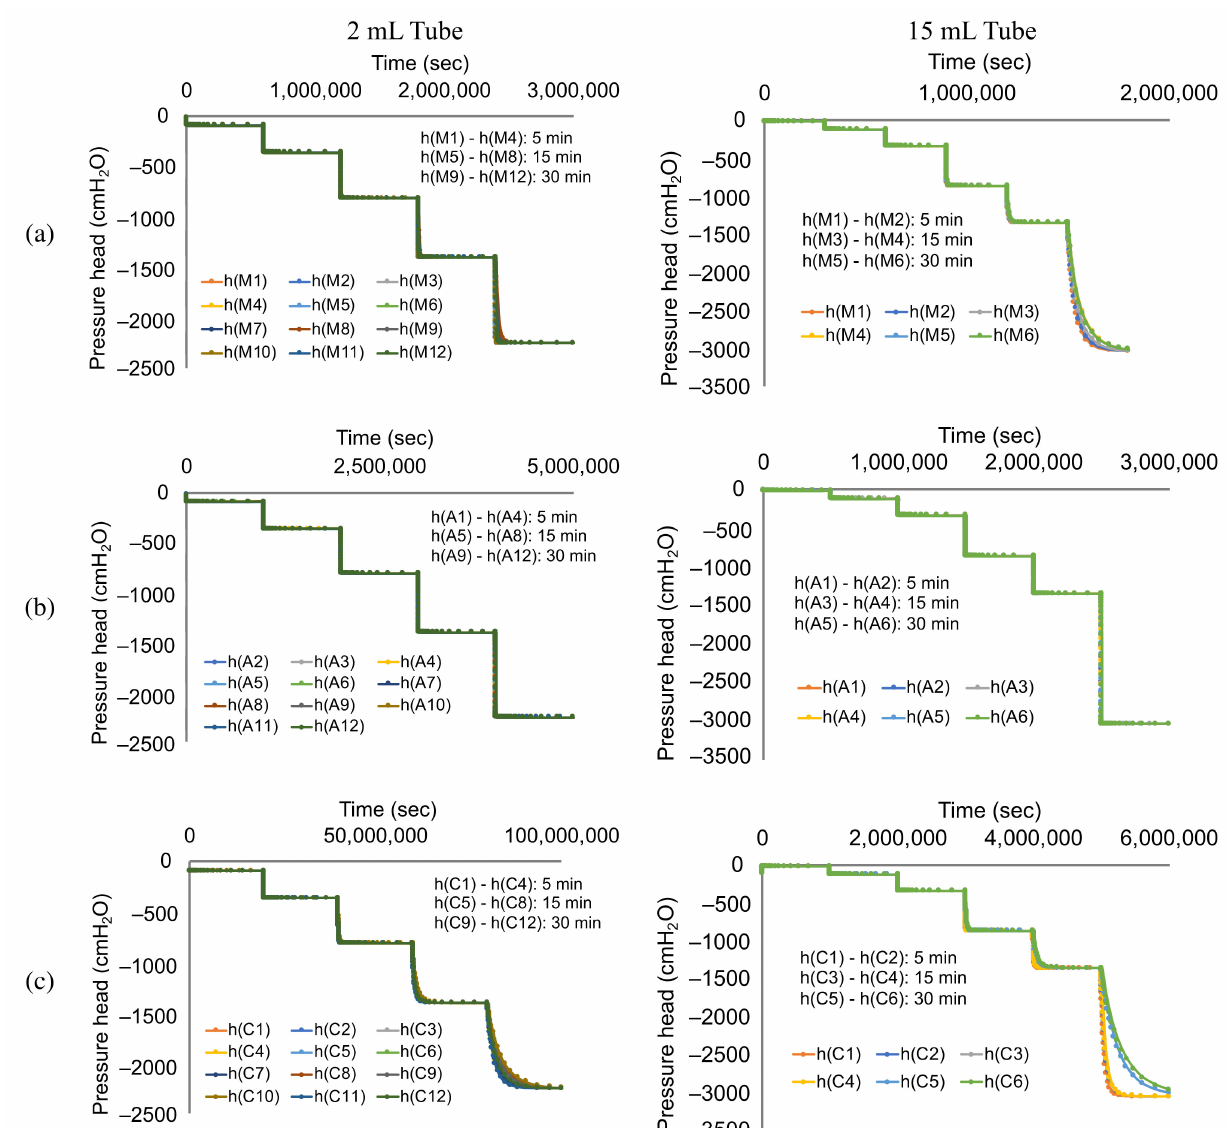
Figure 8. Optimized pressure head as extension time after setup of constant saturated hydraulic conductivity K s of 2 mL and 15 mL tubes: ( a ) Decomposed granite soil (Masa soil); ( b ) Volcanic ash soil (Andisol soil); ( c ) Paddy